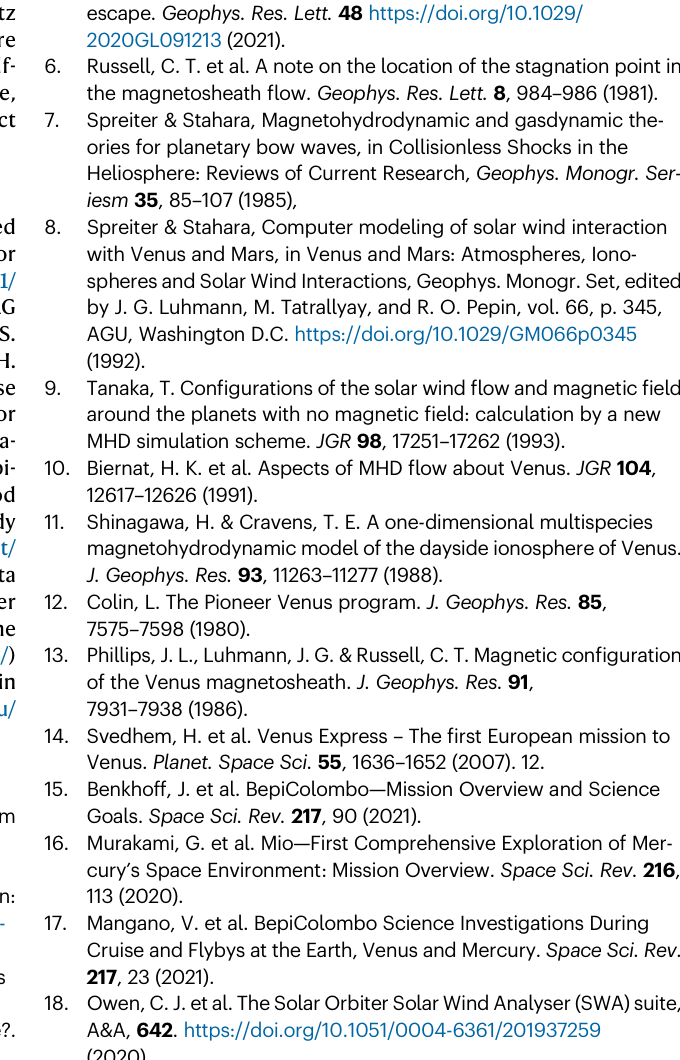
distributions,assumingaclosetozeroVspacecraftpotential,giveatemperatureof 34eV for the electrons (which is also strengthened by the approximation that the temperature equals the peak energy, here about 70eV, divided by two 51 ) and 280eVfortheions.Theelectronmeasurementsbelow10eV(reddots)correspond toapopulationofphotoelectrons( e (cid:2) ph )attachedtoMioduetospacecraftcharging and is not included in the fi